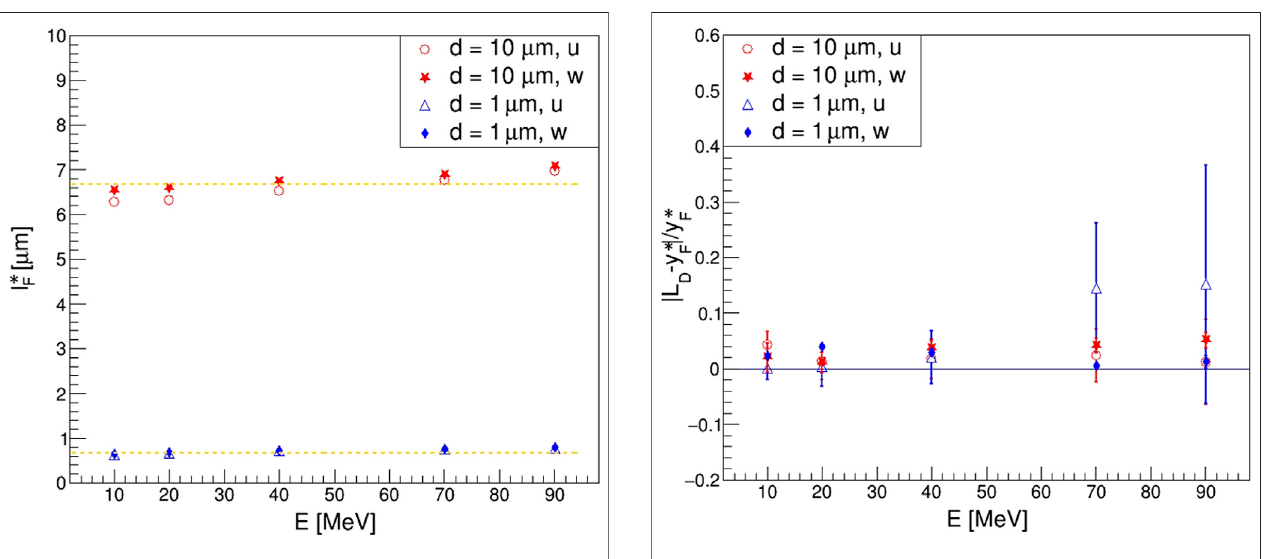
FIGURE 13 | Relative residuals of (cid:1) L D from (cid:1) y * F for the different site diameters and sampling methods